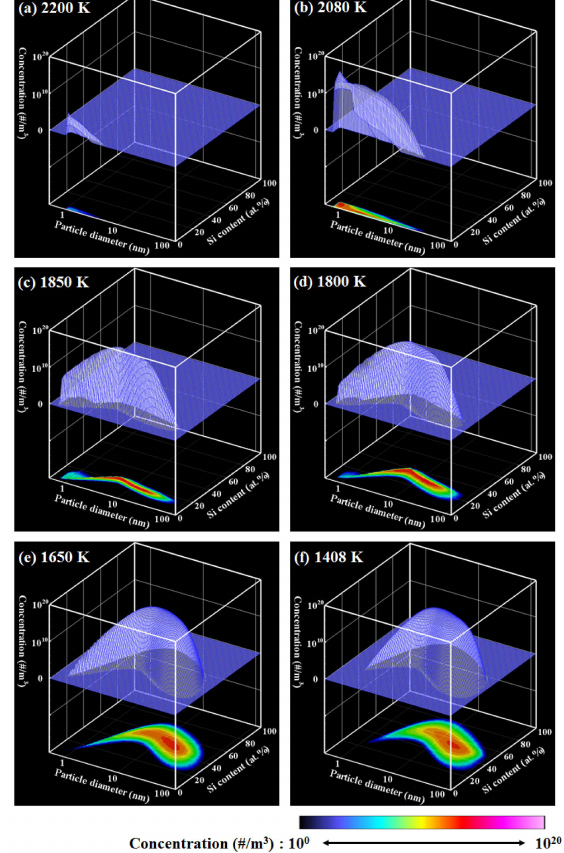
Figure 4. PSCD evolution for ζ = 10 3 .